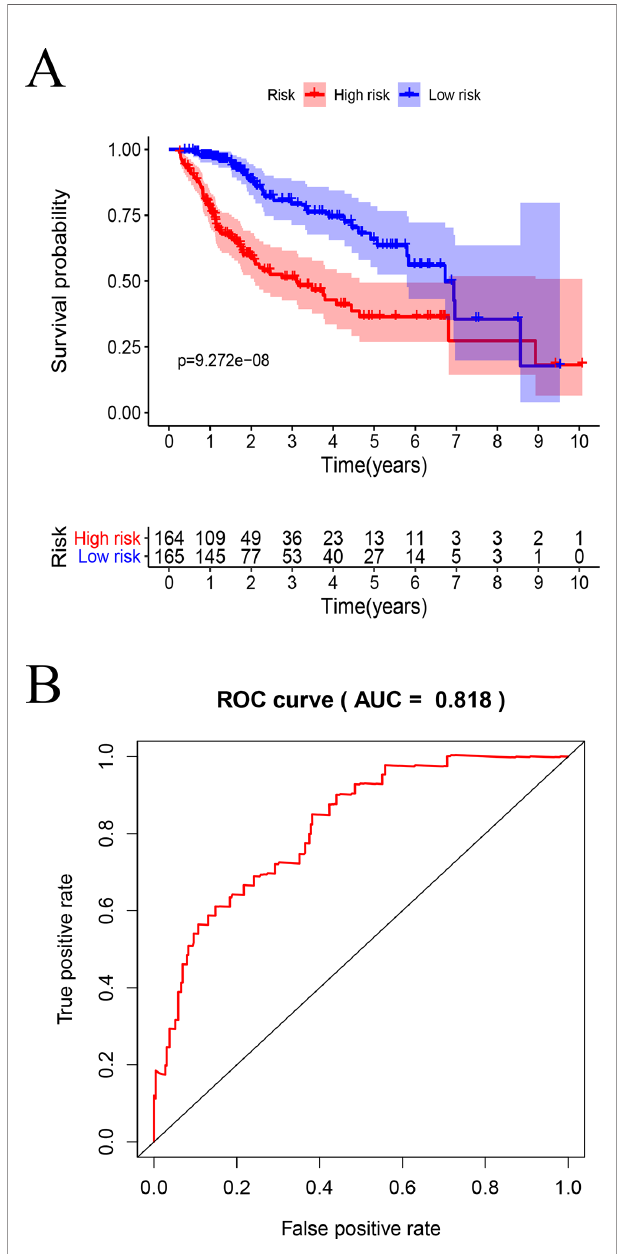
FIGURE 9 | Survival analysis by the prognostic model: (A) Kaplan – Meier analysis using high- and low-risk score groups of patients with HCC. (B) ROC curve analysis.